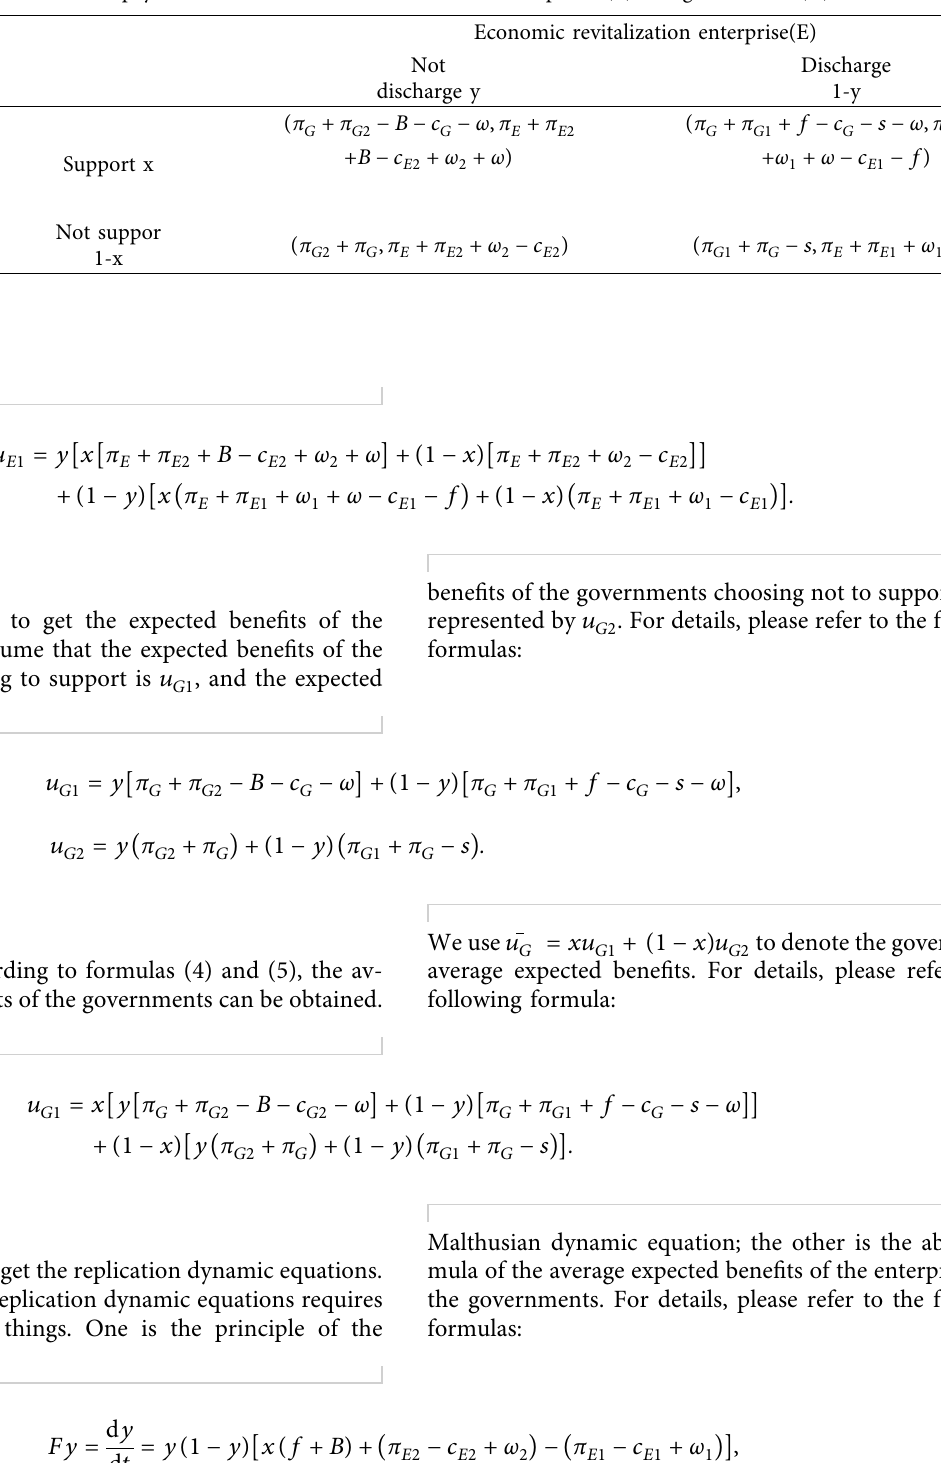
Table 2: Game payoff matrix of economic revitalization enterprises (E) and government